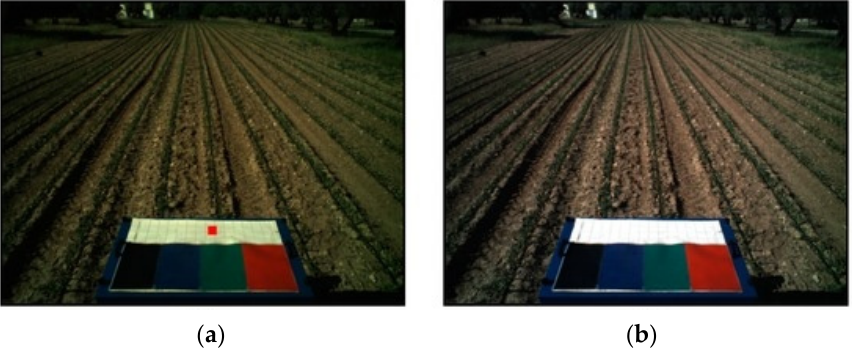
Figure 5. Example of auto-calibration process: ( a ) original image, ( b ) corrected image [64].